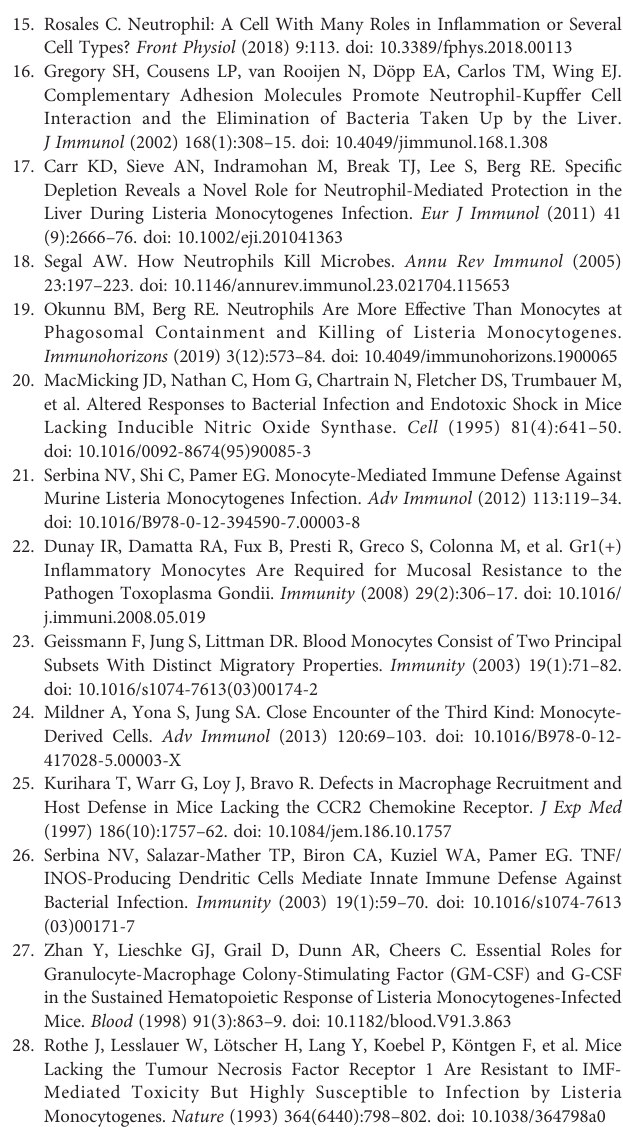
Supplementary Figure 5 | ǀ Phagocytic capacity of in fl ammatory monocytes following in vivo Listeria monocytogenes infection is largely independent of ADAP. Wild type ( ▪ ) and ADAPko ( ▫ ) mice (age: 10-17 weeks) were infected i. v. with 2.5 × 10 4 CFU Lm (strain 10403S) and sacri fi ced at the indicated times post infection. Leukocytes were isolated from spleen and liver, stained for CX3CR1 low Ly6C high in fl ammatory monocytes in reference to CD45 + Lin - Ly6G - CD11b + cells and phagocytosis of CX3CR1 low Ly6C high cells was assessed by a 2 h incubation of the cells with carboxylate-modi fi ed FITC- fl uorescent latex microspheres at 37°C or 4°C serving as negative controls (ctr.) with a cell to bead ratio of 1:5. (A) Representative histograms for spleen (left histograms) and liver (right histograms) for CX3CR1 low Ly6C high in fl ammatory monocytes in wild type and ADAPko mice in addition to the related negative control 1 and 3 days post Lm infection. Numbers and dotted lines of the (A) histograms and the ( B, C , right panels) bar charts ( > 3 beads, 3 beads, ▪ 2 beads, ▪ 1 bead, ▪ 0 beads) show the fractioned cells according to the amount of incorporated beads. Phagocytic capability of ( B , left panel) spleen and ( C , left panel) liver in fl ammatory monocytes was considered by the MFI of bead-positive populations. Data are depicted as mean ± SEM for n = 6-8 individually analyzed mice per group out of two independent experiments. ( B , C , left panels) Statistical analyses were performed using two-way ANOVA with